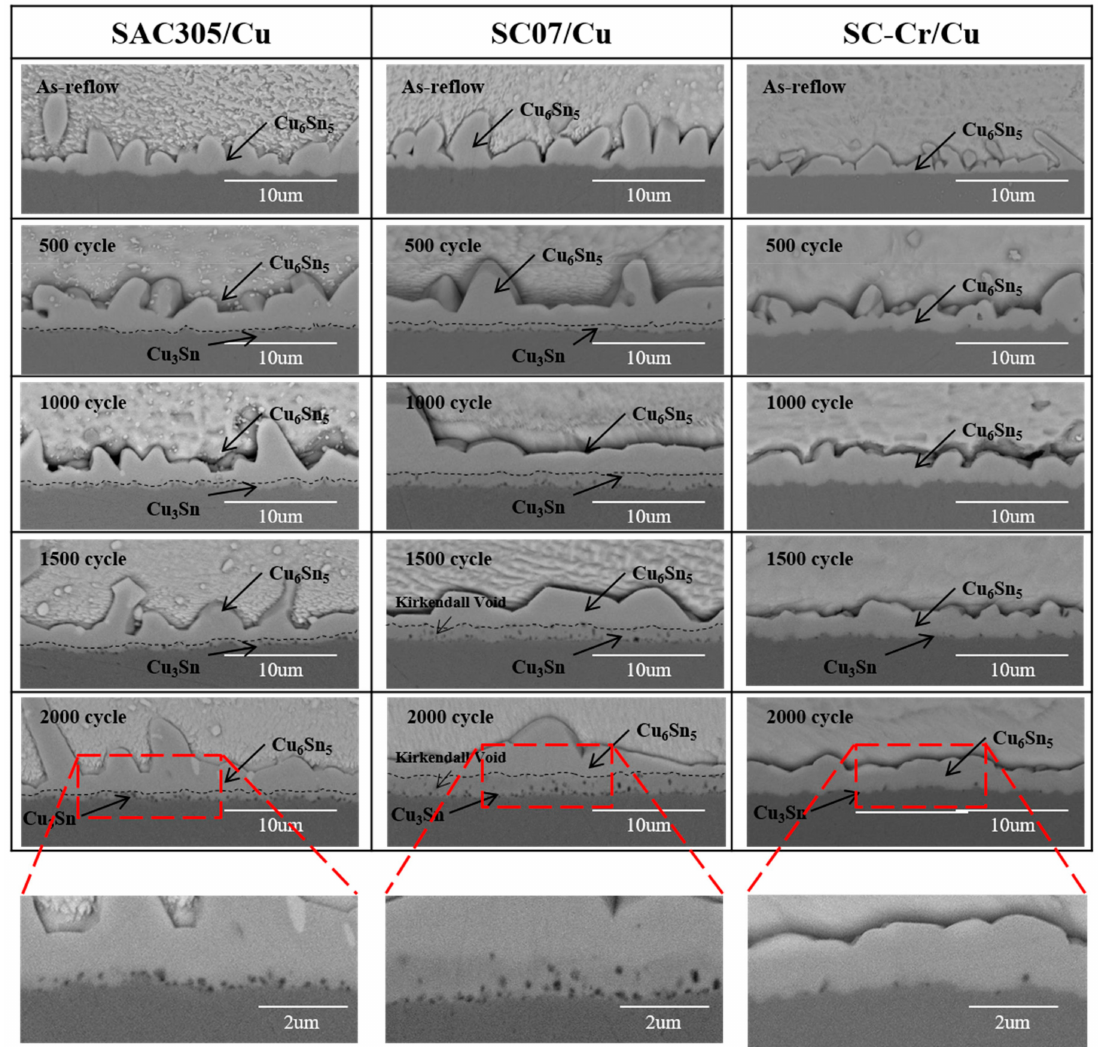
Figure 3. Representative SEM images showing the interfacial microstructures of the solder joints after various cycles of thermal